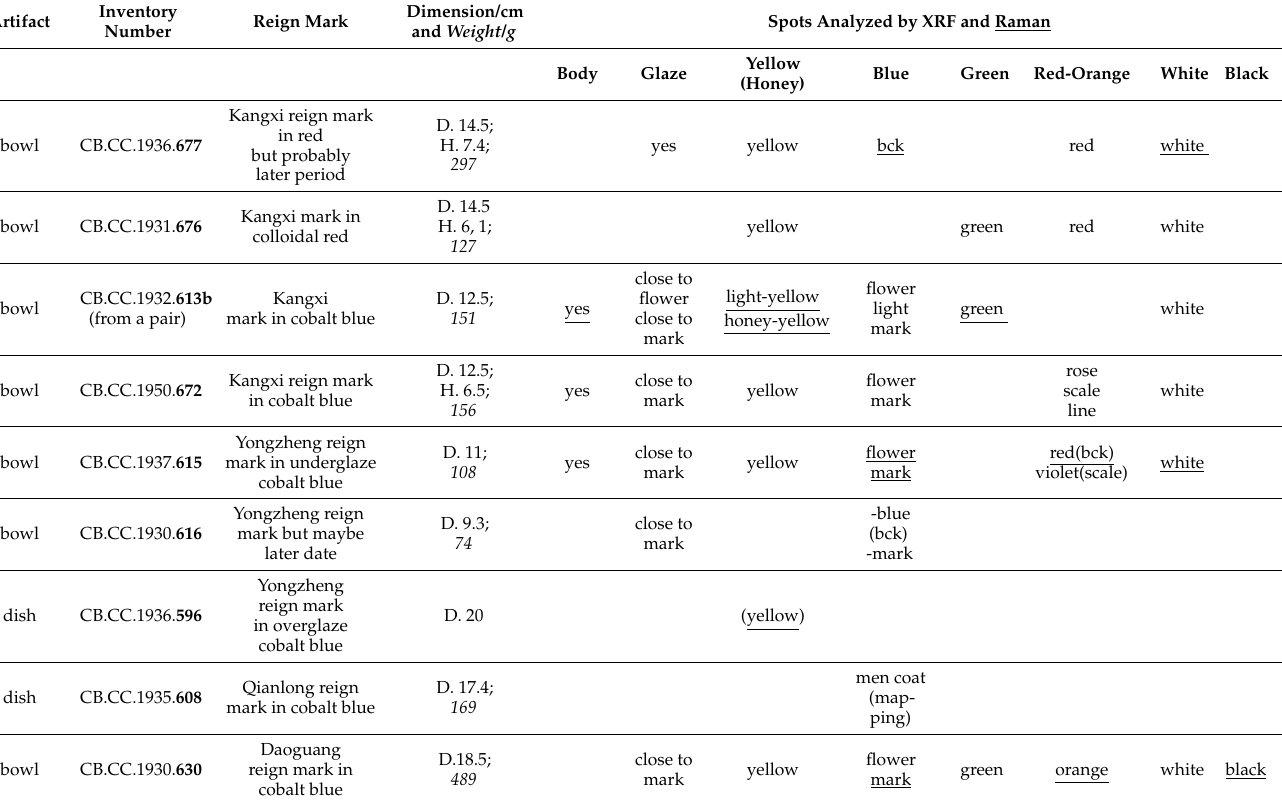
Figure 3. Views of the two dishes under Raman examination (top A608, bottom A596, see Table 1). Table 1. Studied artifacts and their characteristics (inventory numbers are simplified in the text using A followed by the last three-digit number in bold); areas analyzed by XRF and Raman (underlined) spectroscopy are given (bck: background); colored spots only studied with Raman are in brackets and